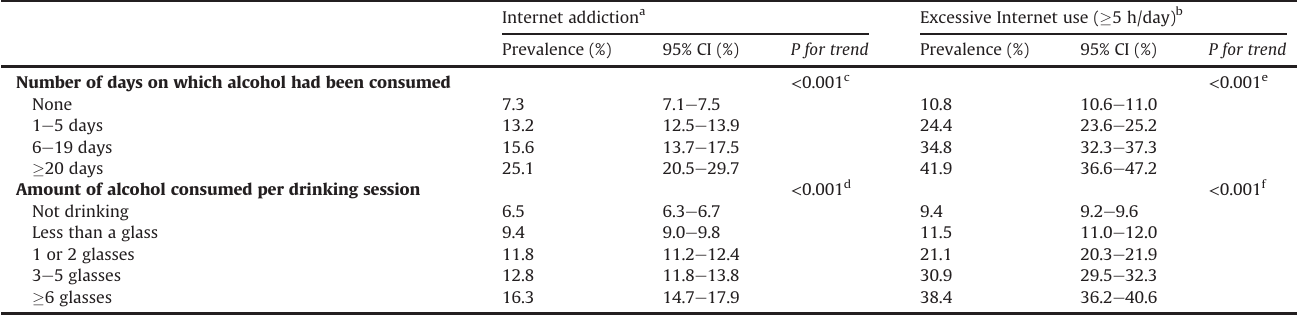
Table 2 Prevalence of Internet addiction and exessive Internet use among Japanese adolescents, based on the number of days on which alcohol had been consumed and amount of alcohol consumed per drinking session. Internet addiction a Excessive Internet use ( (cid:1) 5 h/day) b